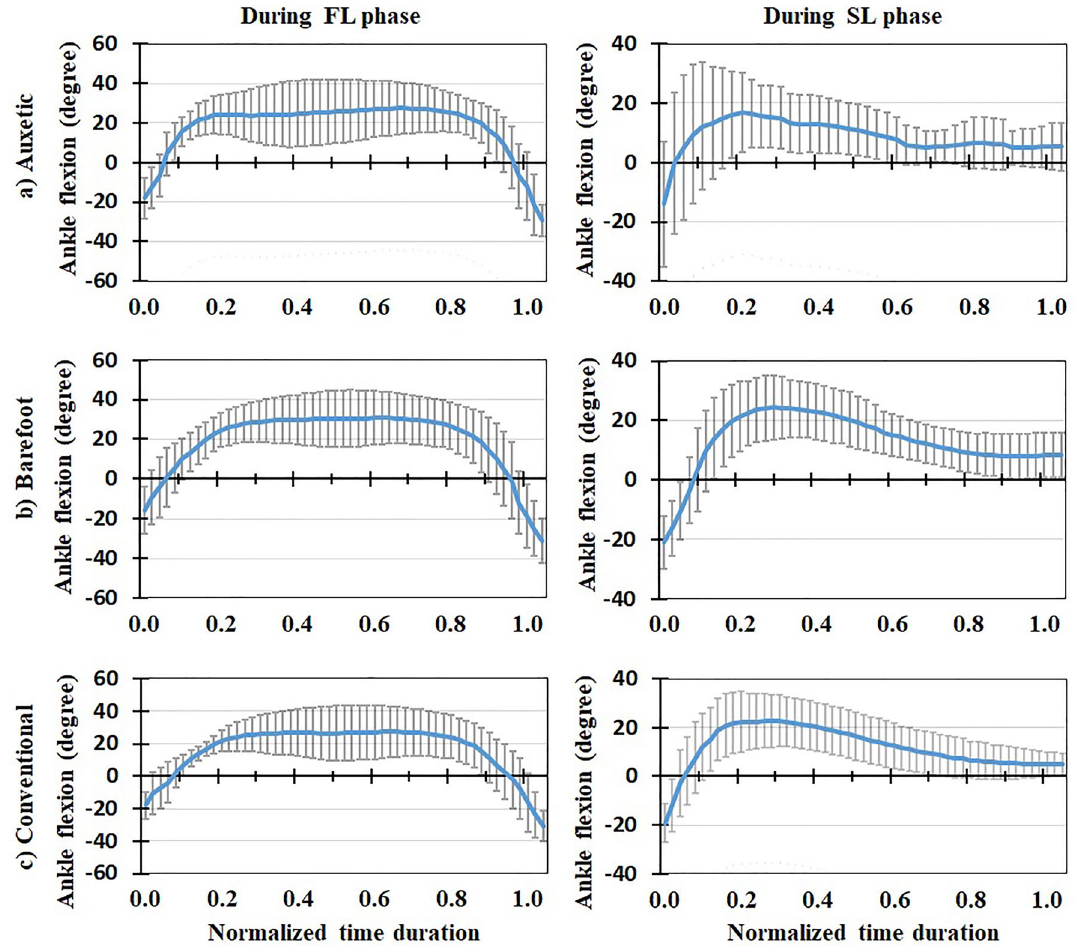
Figure 6. Mean Ankle flexion (degree) for all the participants (+ / − one standard deviation) in three footwear conditions: ( a ) auxetic shoe, ( b ) barefoot, and ( c ) conventional shoe. Left and right plots indicate variations during FL and SL phases of DVJ,